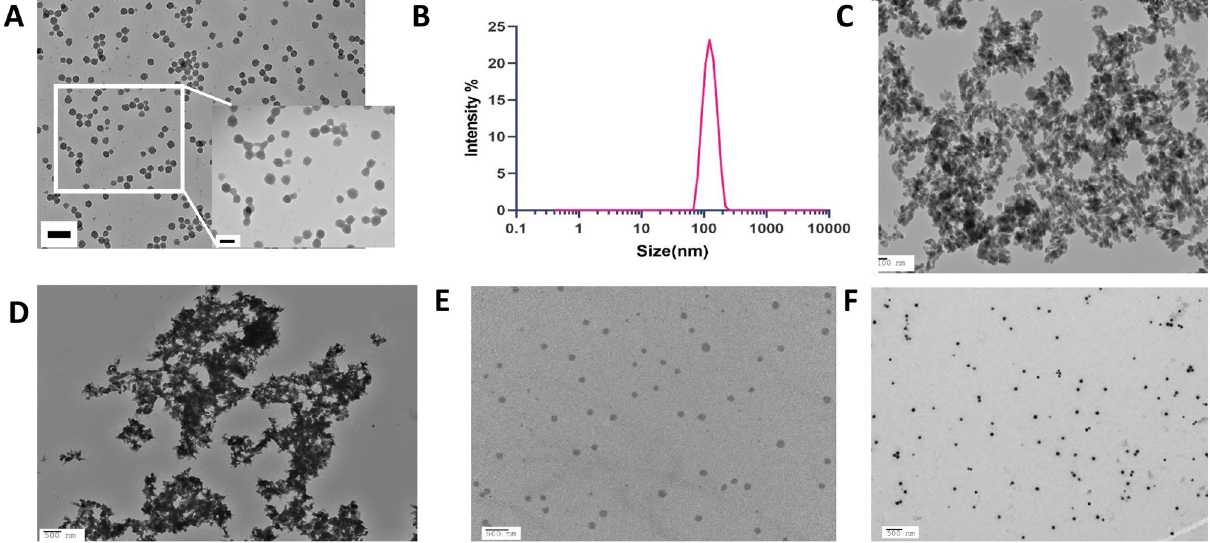
Figure 2. CaCO 3 nanoparticle characterization. ( A ) Transmission electron microscope image of nanoCaCO 3 dispersed in ethanol before drying the nanoparticles shows spherical particles with the size of 78.6 ± 7.6 nm. Scale bar = 200 nm (main panel); 100 nm (inset). ( B ) NanoCaCO 3 were dispersed in ethanol for dynamic light scattering measurement, showing an average intensity-based size of 120.0 nm ± 29.3 nm. Average number of particles-based size measurement is 101.8 ± 24.7 nm (not shown). ( C – F ) TEM images of nanoCaCO 3 after dispersion in distilled water ( C ), PBS ( D ), serum ( E ), and DMEM ( F ); scale bars = 100 nm for ( C ) and 500 nm for ( D – F